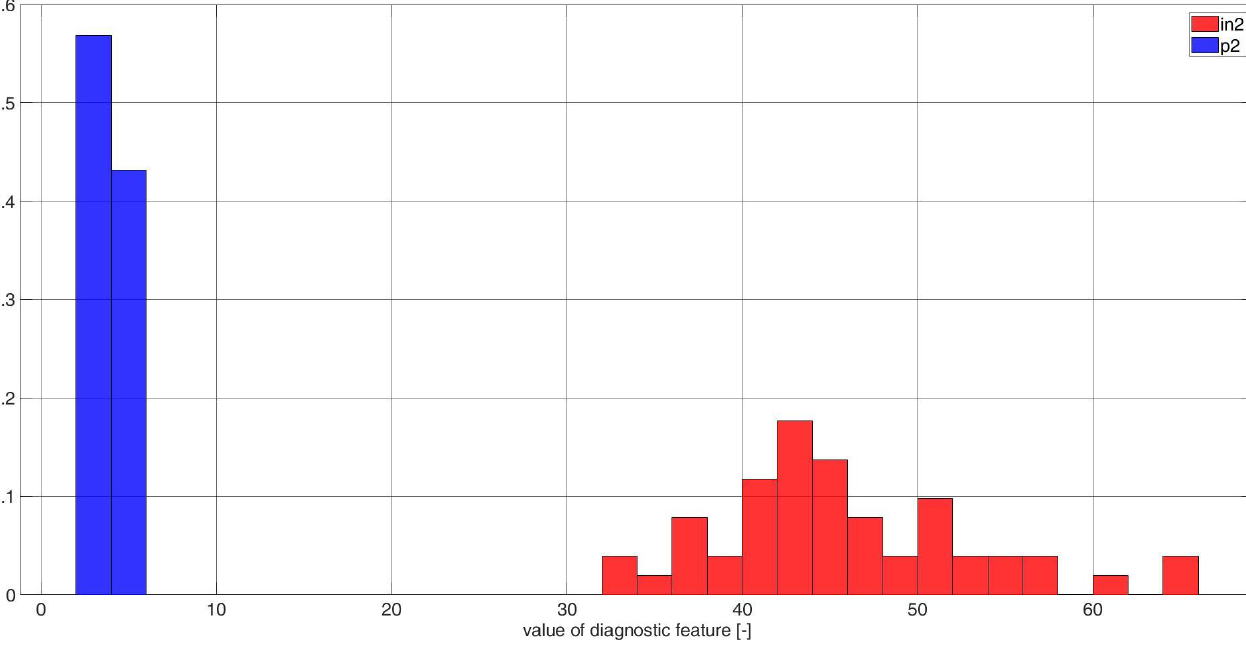
Figure A14. Histograms of diagnostic features based on the CCSM3 (correlation number is 12—Table A1) bearings in2 and p2.